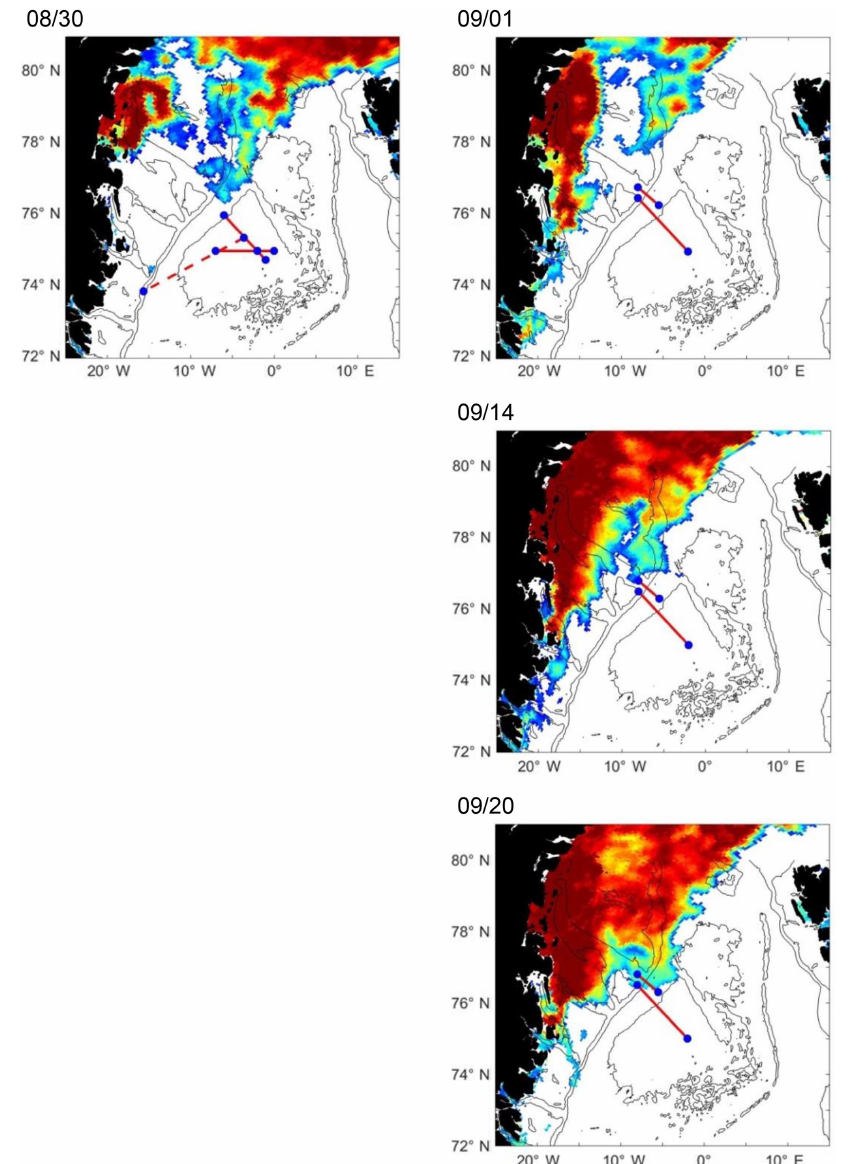
Figure 3. The development of the ice cover in the western Greenland Sea during the time span of the glider missions in summer 2014 and summer 2015. Left column for summer 2014, right column for summer 2015. Month and day of the individual ice concentration maps are given in the upper left corner. The maps are based on ice concentration data made available by Drift+Noise (https://driftnoise.com/). For each year, a sketch of the respective glider sections is added to the map (red lines and blue dots; the red dashed line in the bottom left map shows the track of glider 558 to the recovery position). Black contours give the 3000, 1000 and 300m depth contours based on RTOPO2 (Schaffer et al., 2016). The location of the map is shown as an inlet in Fig. 1 with a blue dashed